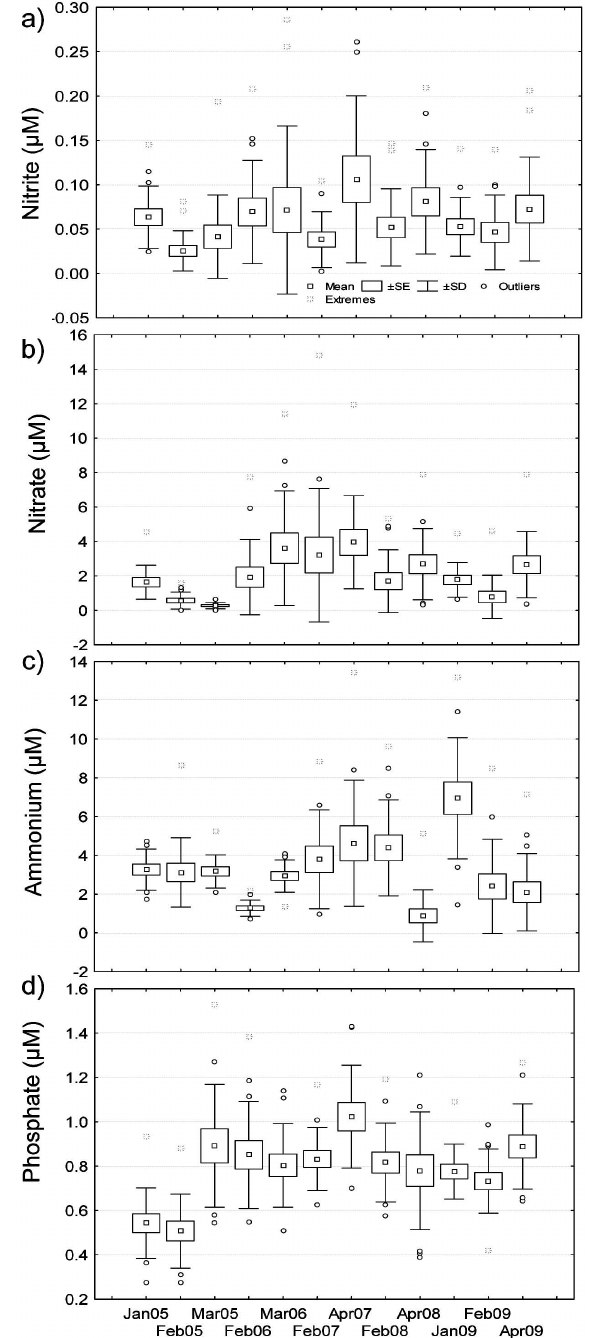
Fig . 4. – Box plots: a) nitrite (µM), b) nitrate (µM), c) ammonium (µM), and d) phosphate (µM) during winter and early spring 2005- 2009 in Bahía Magdalena, Baja California